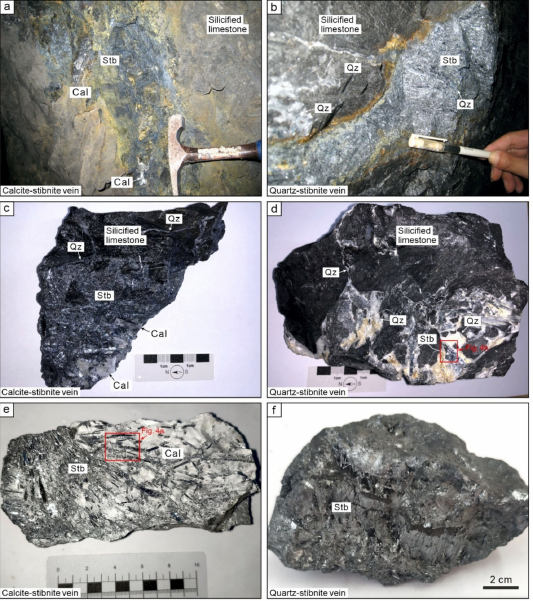
Figure 3. Representative photographs of orebodies and Sb ores in the Xikuangshan Sb deposit. The host rock of both quartz-stibnite vein and calcite-stibnite is silicified limestone. ( a , c , e ) Calcite- stibnite vein and hand specimens. ( b , d , f ) Quartz-stibnite vein and hand specimens. Abbreviations: Qz = quartz, Cal = calcite, Stb =